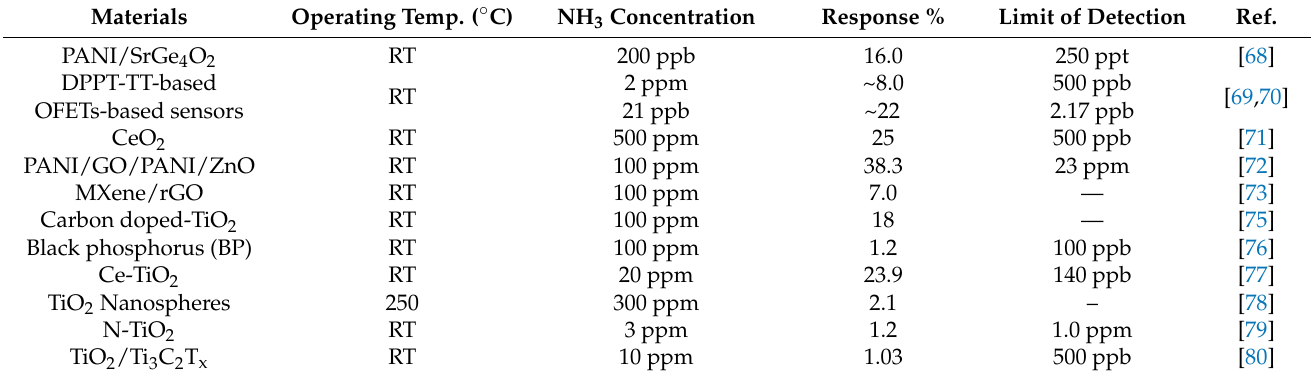
Table 2. The most recent chemiresistive NH 3 sensors reported in the